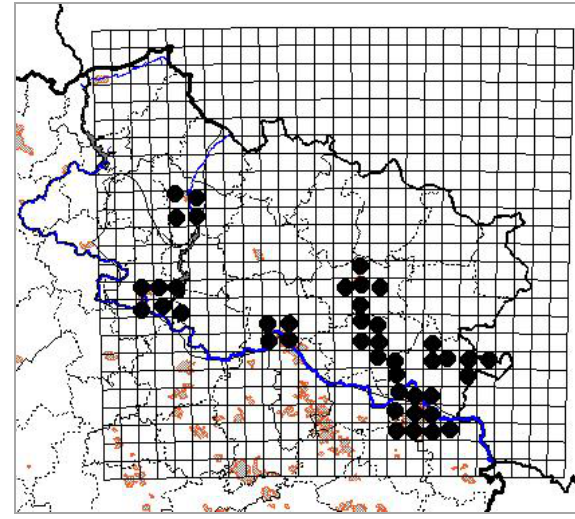
Fig. 23. The map of the distribution of Portulaca oleracea L. in the Starobilsk grass-meadow